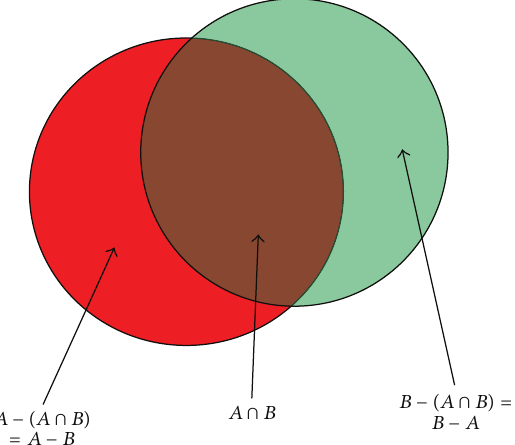
Figure 1: Intersections of two hotspots detected for events that happened in two consecutive